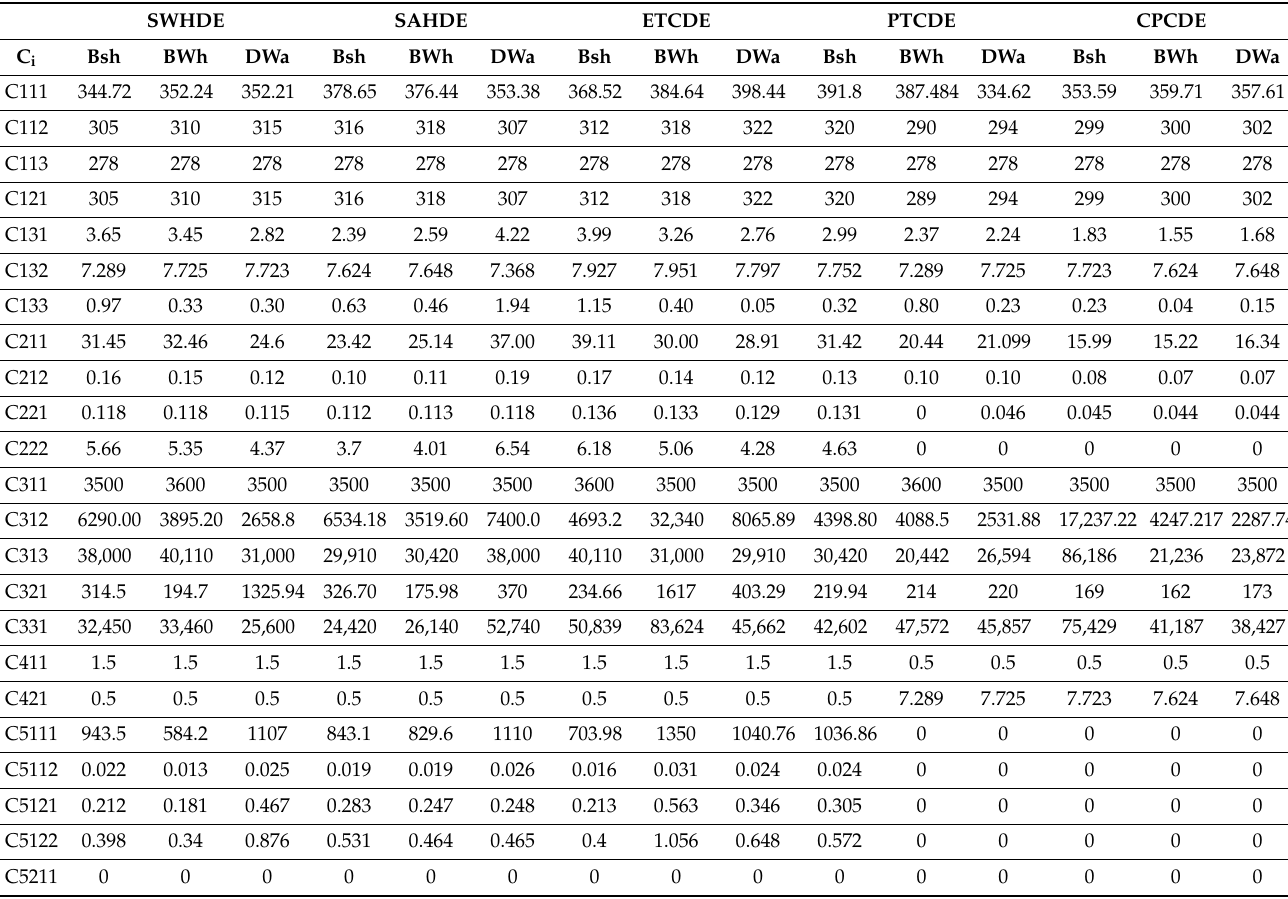
Table 6. Basic attribute values for Niger (Bsh), Riyadh (BWh) and Beijing (DWA) climate zone for double effect